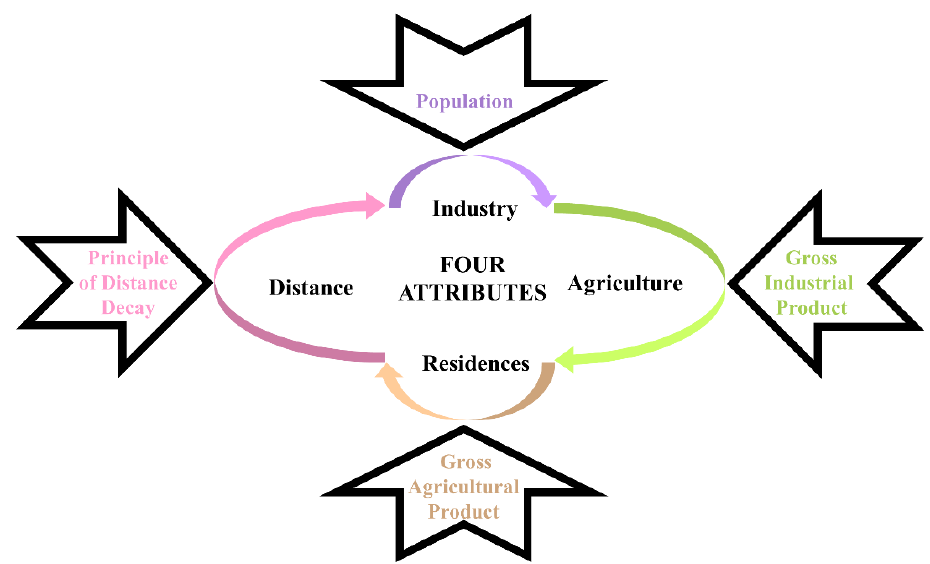
Figure 5. There are four main attributes that correspond to indicators in the distribution of power. When considering the geographic location factor, we introduce the Distance Decay Law (DDL). The essence of the DDL is that the interaction between geographic elements is related to distance, and the interaction between geographic elements is inversely proportional to the square of distance when other conditions are the same [41]. The theoretical basis of the DDL is the formula of universal gravitation discovered by Newton. We counted the distance from 193 counties to the two dams, and also combined the power resource allocation principles to quantify the distance index and transformed the distance merit into 10 levels from 1 to 10 points. Figure 6 graphically illustrates this work.